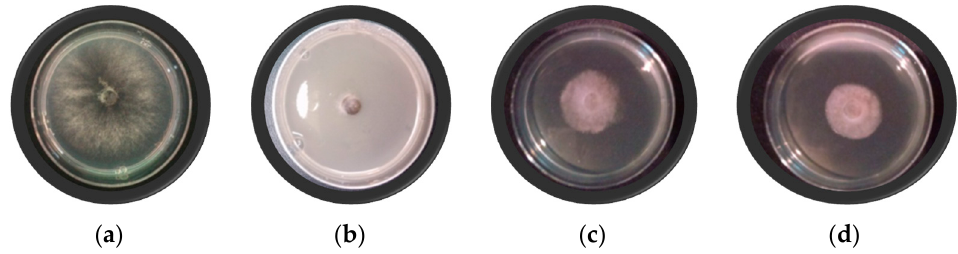
Figure 8. Effect of hydrated geranylphenol 26 on the in vitro mycelial growth of B. cinerea . ( a ) Negative control; the medium contains only Potato Dextrose Agar (PDA) and 1% ethanol. ( b ) Positive control; Captan at 250 ppm. ( c ) Compound 26 at 150 ppm. ( d ) Compound 26 at 250 ppm.